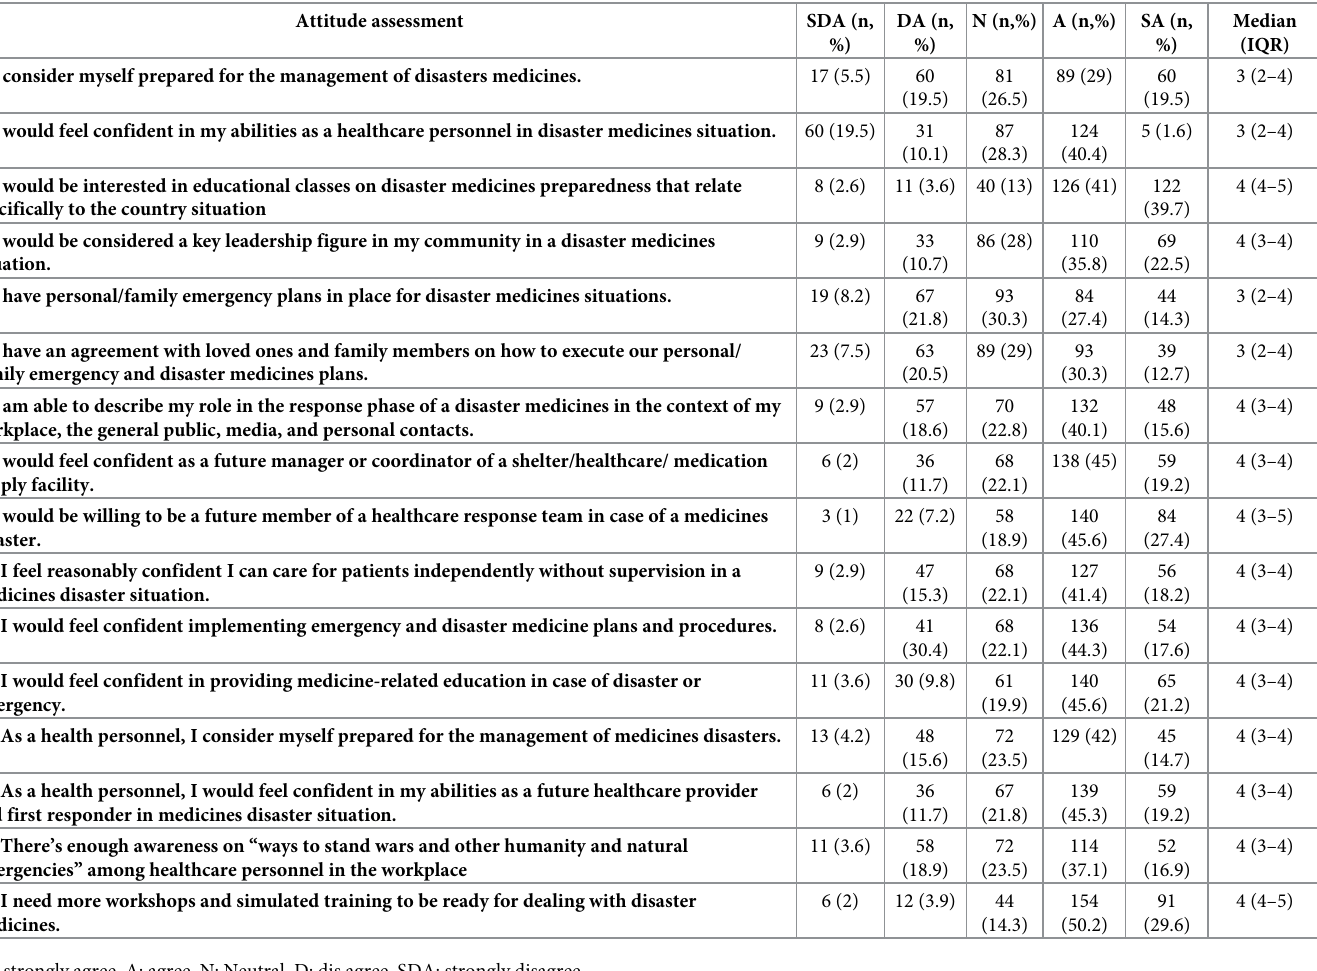
Table 2. Attitude among HCPs on medicine